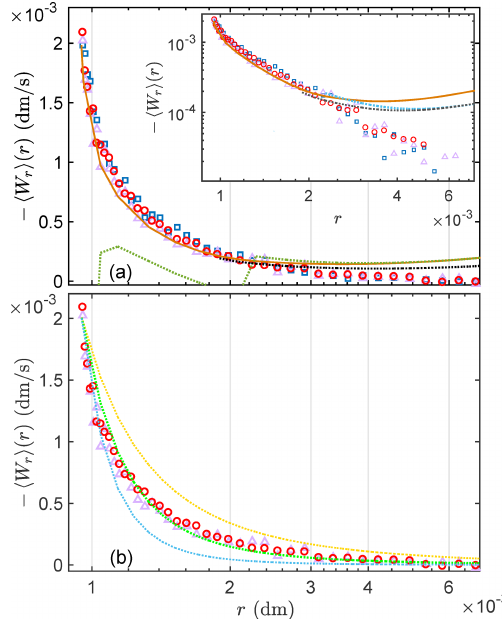
Figure 2. Mean radial component of relative velocity (MRV) for particles of specific Stokes numbers and some theoretic numeri- cal predictions. (a) Symbols are DNS results with (cid:52) : St = 0 . 001; (cid:13) : St = 0 . 054; (cid:3) : St = 0 . 11. The lines are the numerical predic- tions by the theories (Eqs. 9 or 13) using the ansatz (details in text). Orange line: (cid:104) W r (cid:105) theory , i.e., the numerical prediction via r ∼ d, St = 0 . 054 the integral version of the theory (Eq. 9) for the small r regime ( r ∼ d ). Black line: (cid:104) W r (cid:105) theory , same as the previous but for r (cid:29) d, St = 0 . 054 the large r regime ( r (cid:29) d ). Green line: prediction of the differential version of the theory (Eq. 13) for the r ∼ d regime. Inset: a repeat of the main figure in log–log axes. Exception: cyan line is the pre- diction of the differential version of the theory but for the r (cid:29) d regime. (b) MRV compared with predictions via the phenomeno- logical model of particle approach angles (Eqs. 11 and 12). DNS re- sults: (cid:52) : St = 0 . 001; (cid:13) : St = 0 . 054. Dotted lines are model predic- tions of (cid:104) W r (cid:105) St = 0 using Eqs. (11) and (12) with variance K obtained by matching the model’s and DNS’s transverse-to-longitudinal ratio of structure functions (TLR) of a certain order (from the top: yellow line – order 2, green line – order 4, cyan line – order